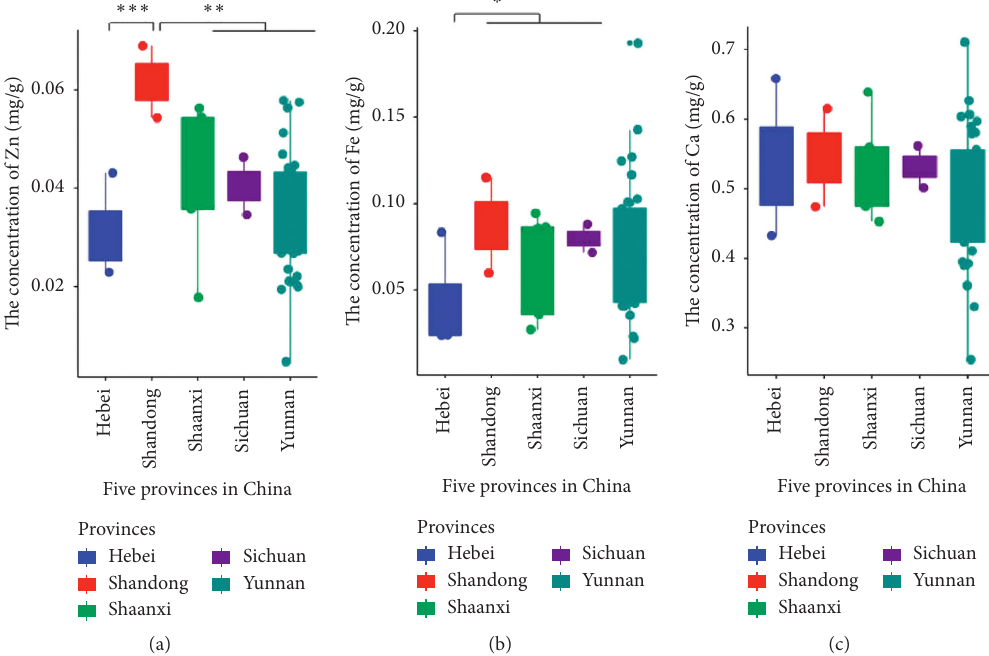
Figure 3: The trace elements (a) zinc, (b) iron, and (c) calcium in 45 different types of walnut kernels from the main five walnut-planting provinces in China. Dunnett’s multiple-comparison tests were implemented for statistical analysis. Raw p value was labeled, ∗ p < 0 . 05, ∗∗ p < 0 . 01, and ∗∗∗ p < 0 . 001.